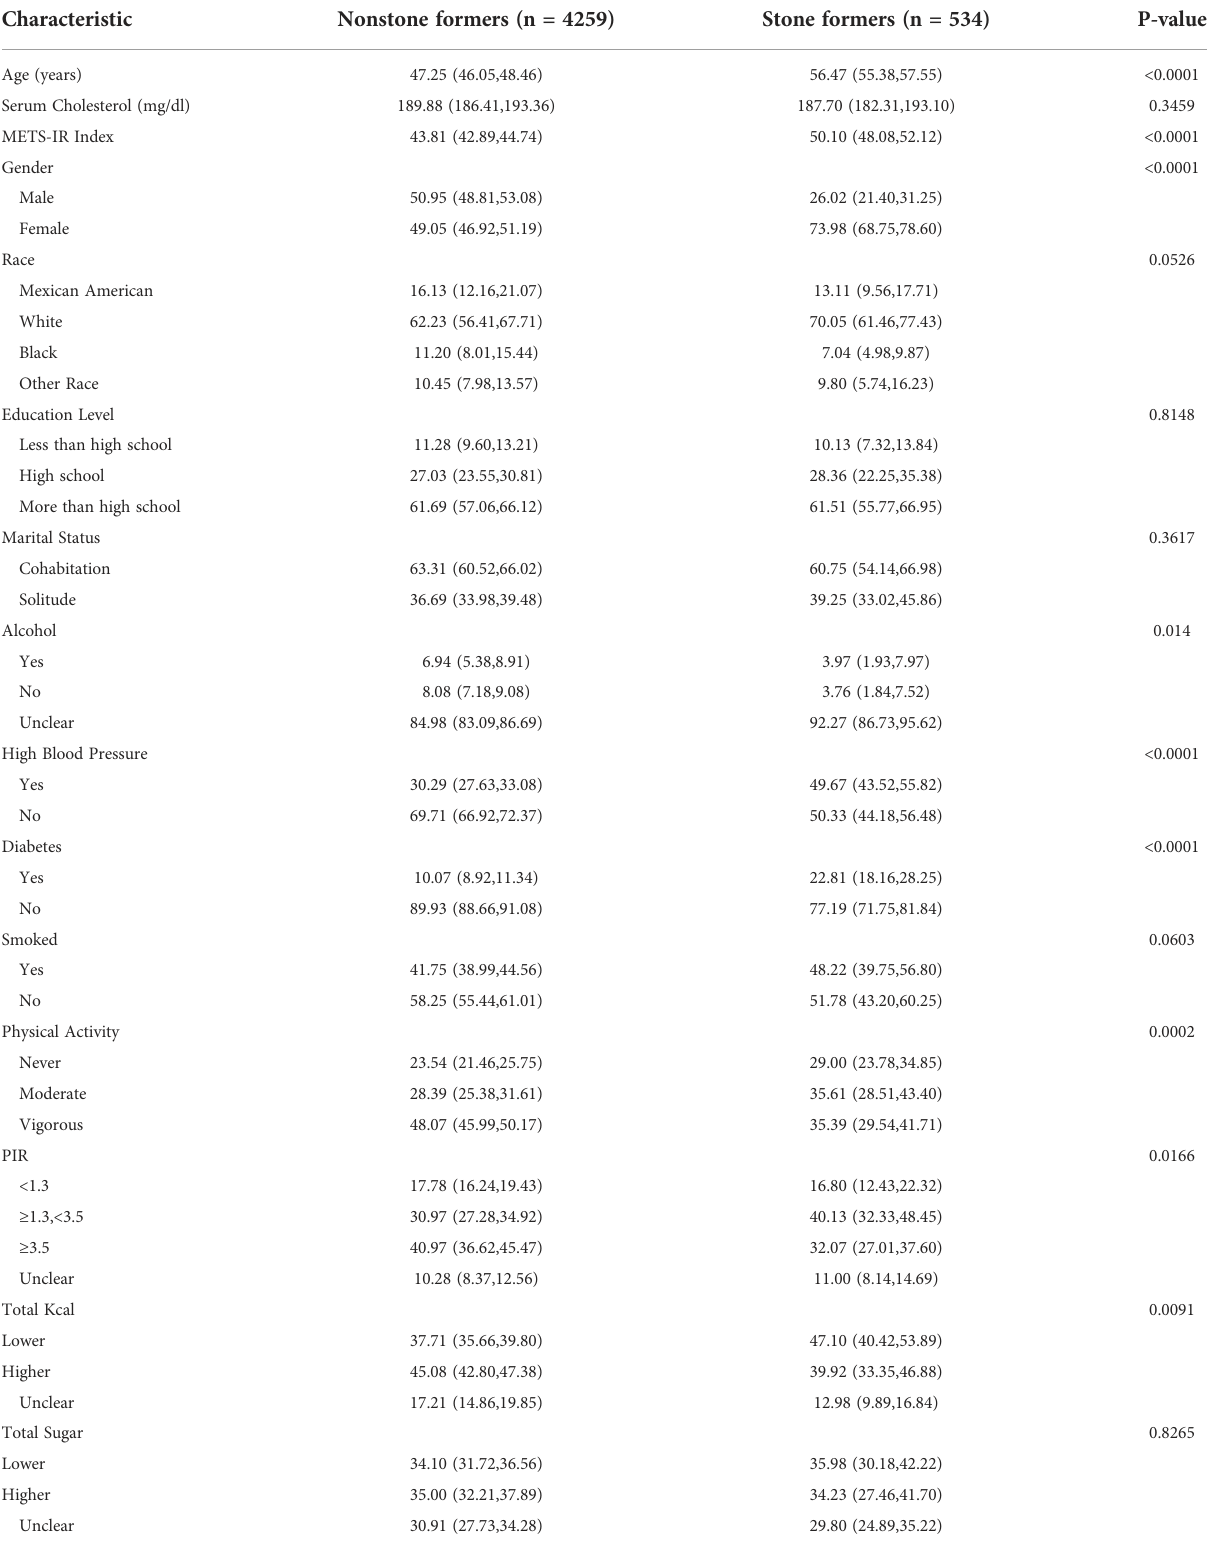
TABLE 1 Baseline characteristics of participants,